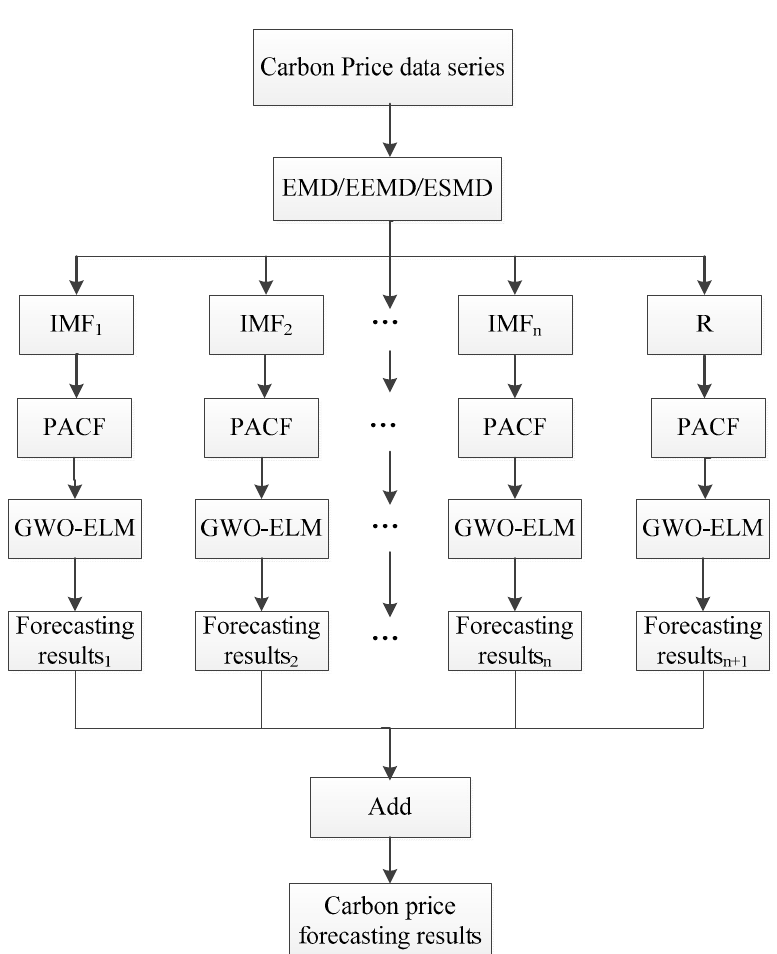
Figure 3. The forecasting process for carbon price with ESMD-GWO-ELM model.